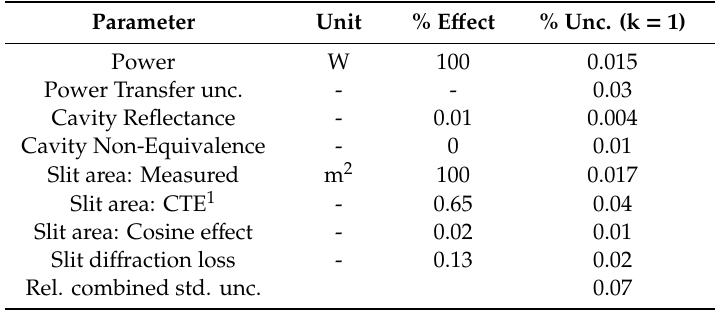
Table 6. CR uncertainty budget operating in irradiance (W / m 2 ) at 532 nm. Parameter Unit % E ff ect % Unc. (k = 1) Power W 100 0.015 Power Transfer